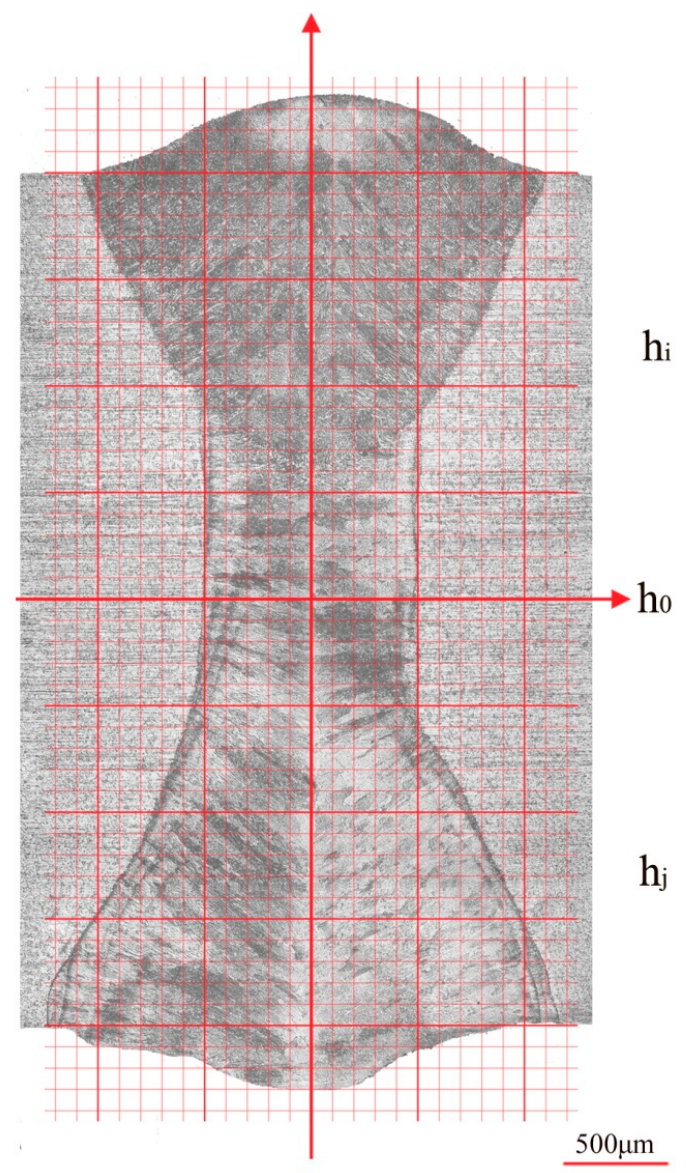
Figure 5. The profile measurement of case S1 by using a cartesian coordinate system. Table 1. The coordinate values of the cross-sectional profile of case S1. (Unit: mm).